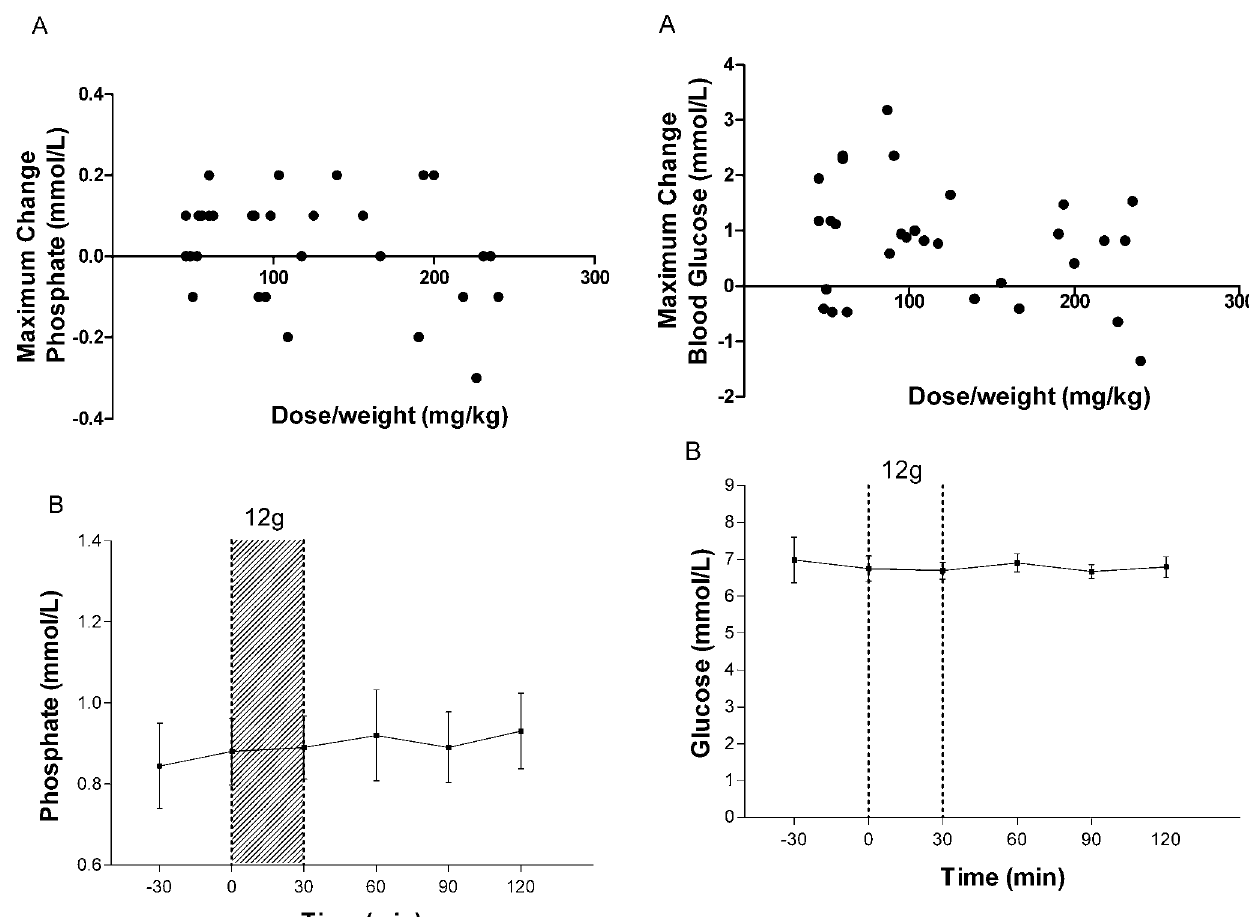
Figure 8. Effects of L-arginine hydrochloride infusion on blood glucose concentrations. Figure 8A: Relationship between dose/ weight (mg/kg) of infused L-arginine and the maximal decrease in whole blood glucose concentration at any time during or in the two hours following infusion (n=30; r= 2 0.27, p=0.14). Figure 8B: Whole blood glucose concentrations of patients before and after 30 minute administration of the highest dose of L-arginine (12 g; n=10). Shaded area indicates time of L-arginine infusion. Dots and bars indicate mean 6 SEM.